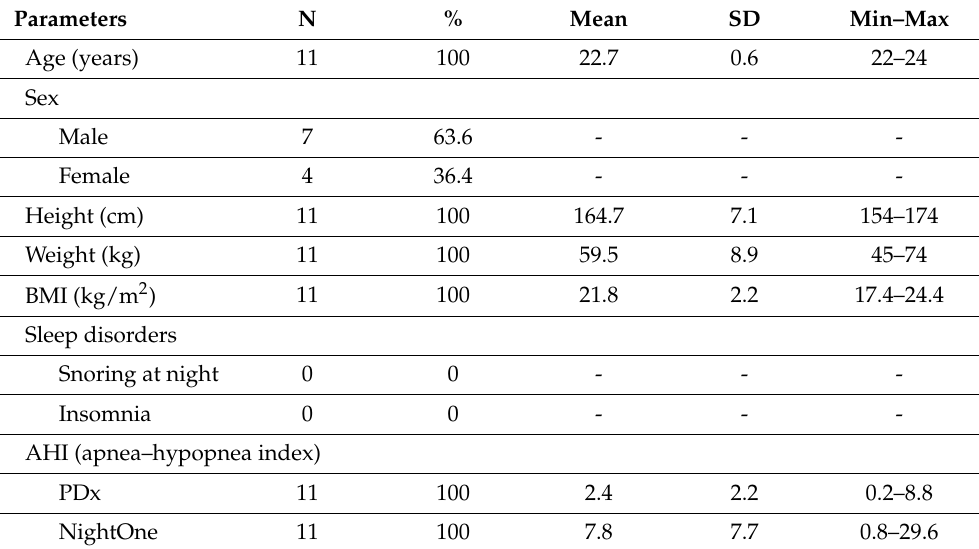
Table 1. Demographic characteristics of study subjects and their AHI measured by